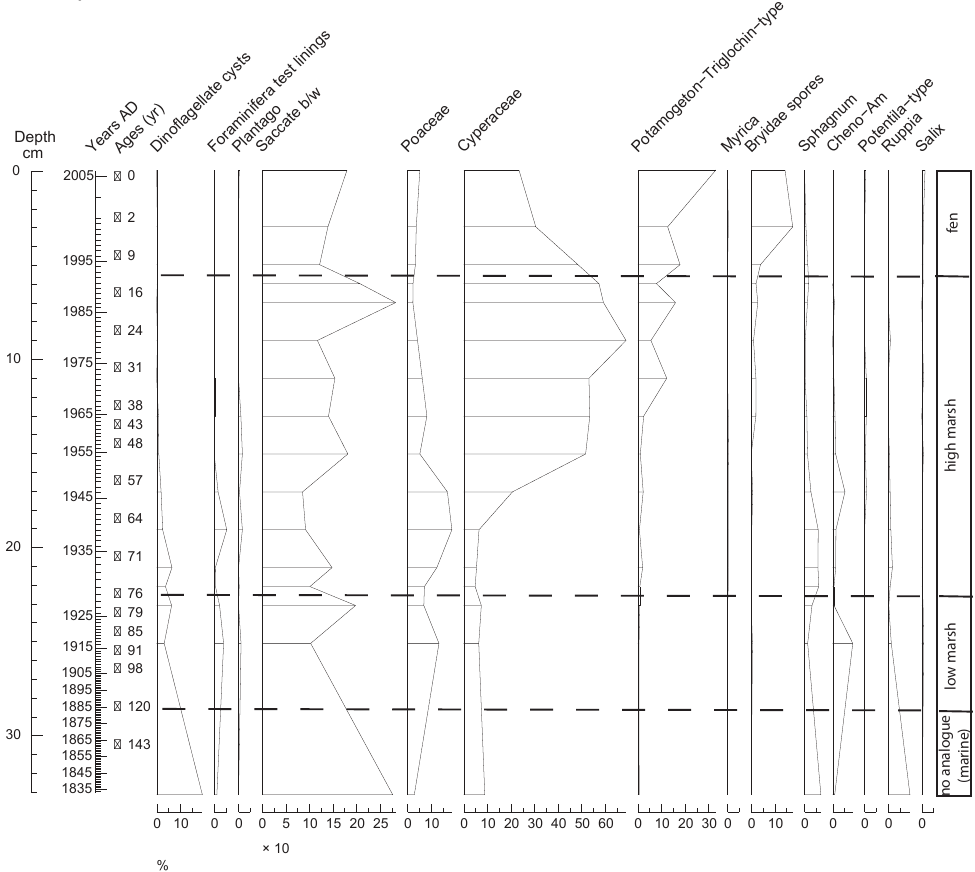
Figure 2. Percentages of plant pollen, spores and dinoflagellate cysts used in the discriminant analysis classifying paleo-wetland communities determined within the AMC core from James Bay, Quebec. Percentages are based on a sum of all plant pollen and spores, excluding Sphagnum . The % Saccate b/w, representing broken conifer pollen prevalent in tidal sediments, is multiplied by 10 for clarity. Note that the age axis, expressed in calendar years, is presented to correspond to appropriate depths, thus is not